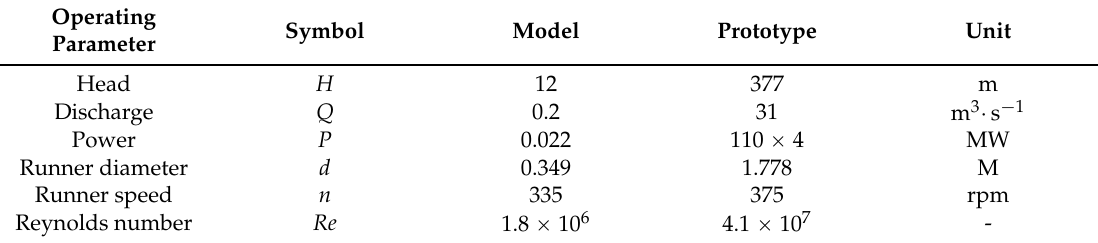
Table 1. Operating parameters of the model and prototype Francis turbines at